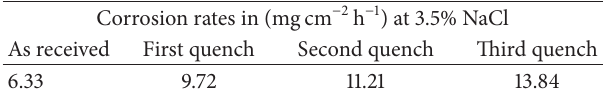
Table 3: Corrosion rate in (mgcm − 2 h − 1 ) data obtained from weight loss measurements for different microalloy steel in 3.5% NaCl solutions at room